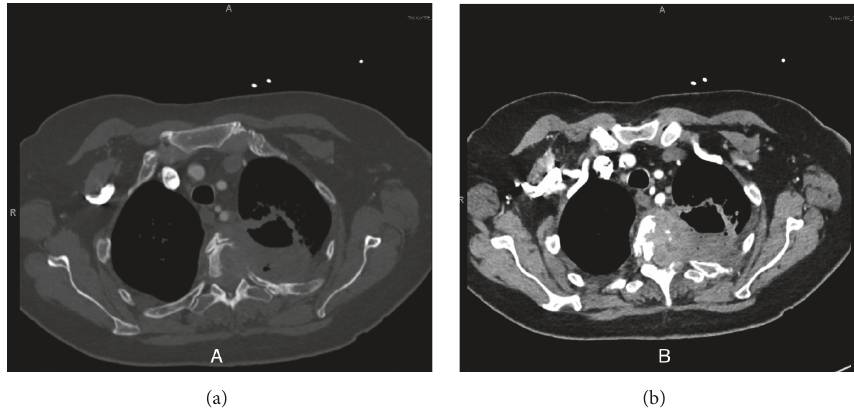
Figure 1: Computed tomography (CT) of the chest in the axial plane with (a) bone window and (b) soft tissue window.